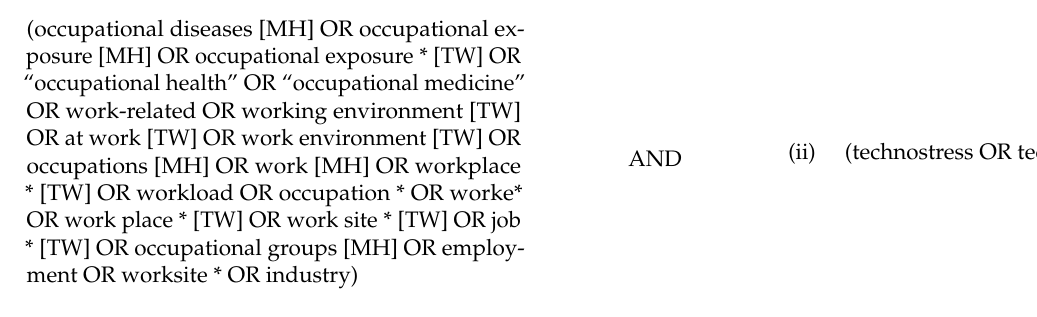
Table A2. Search strategy (PubMed and PubMed Central, slightly adapted for other